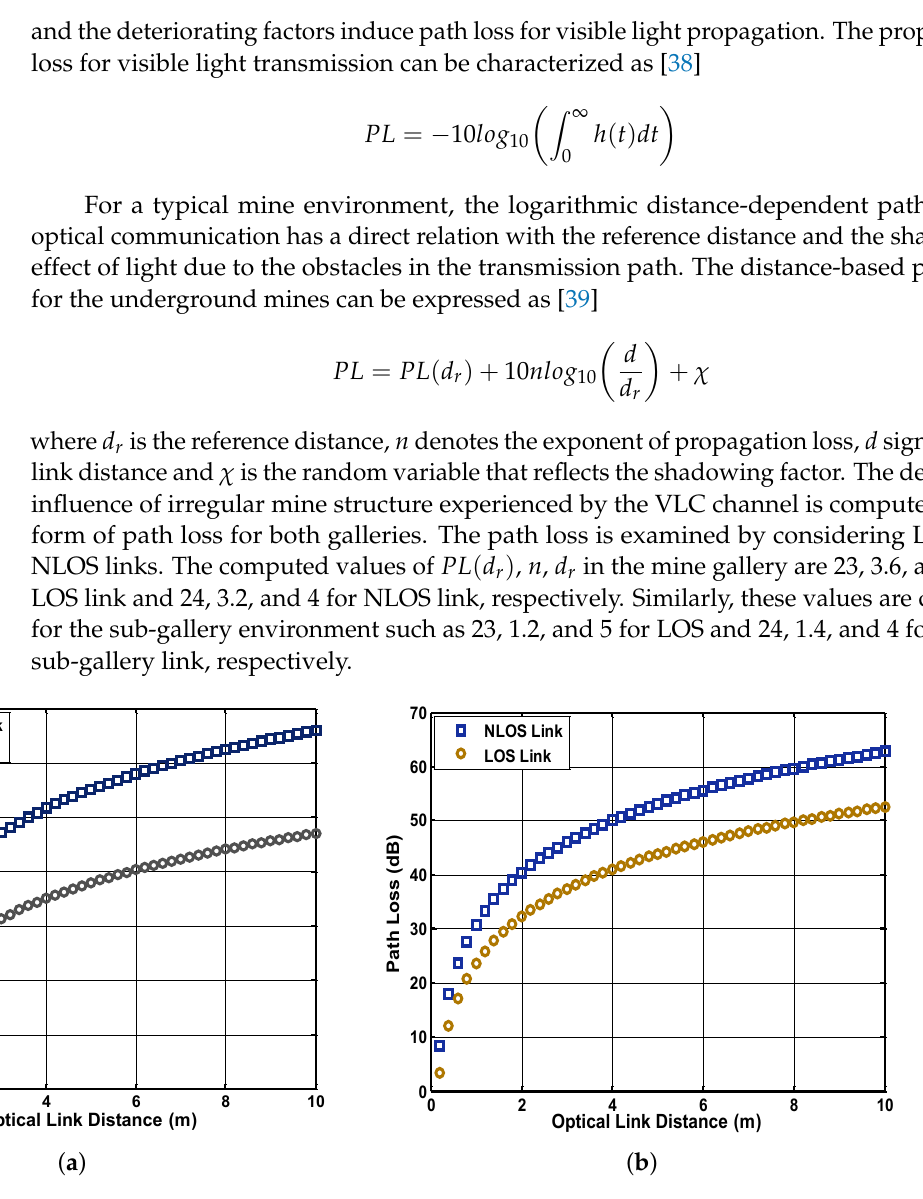
Figure 10. Distance dependent path loss in mine; ( a ) path loss in mine gallery; ( b ) path loss in